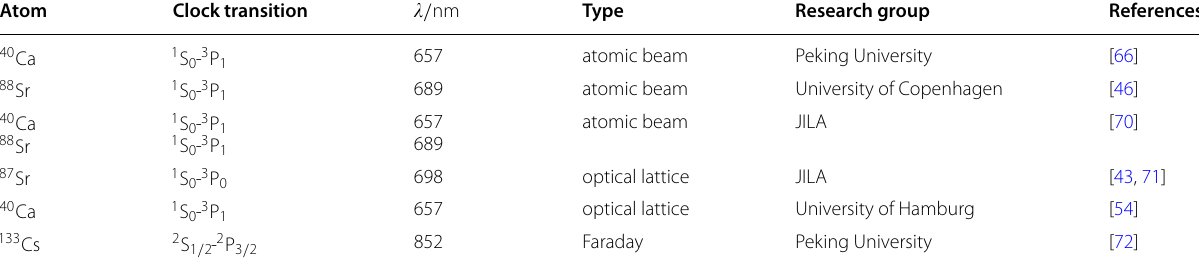
Table 1 Properties of selected two-level AOC, including the clock transitions, their wavelengths, and working types. The corresponding research groups and references are also